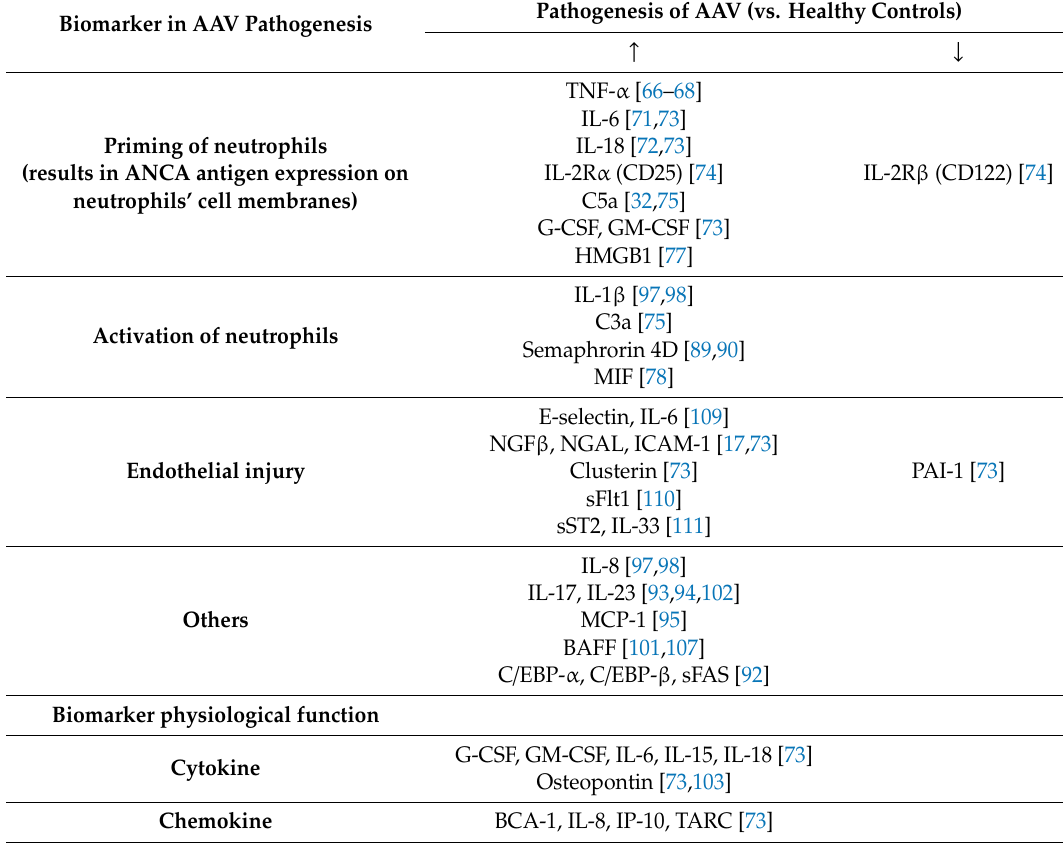
Table 2. Summary of inflammatory molecules with common expression profiles in PR3- and MPO-ANCA vasculitis according to the pathogenesis of